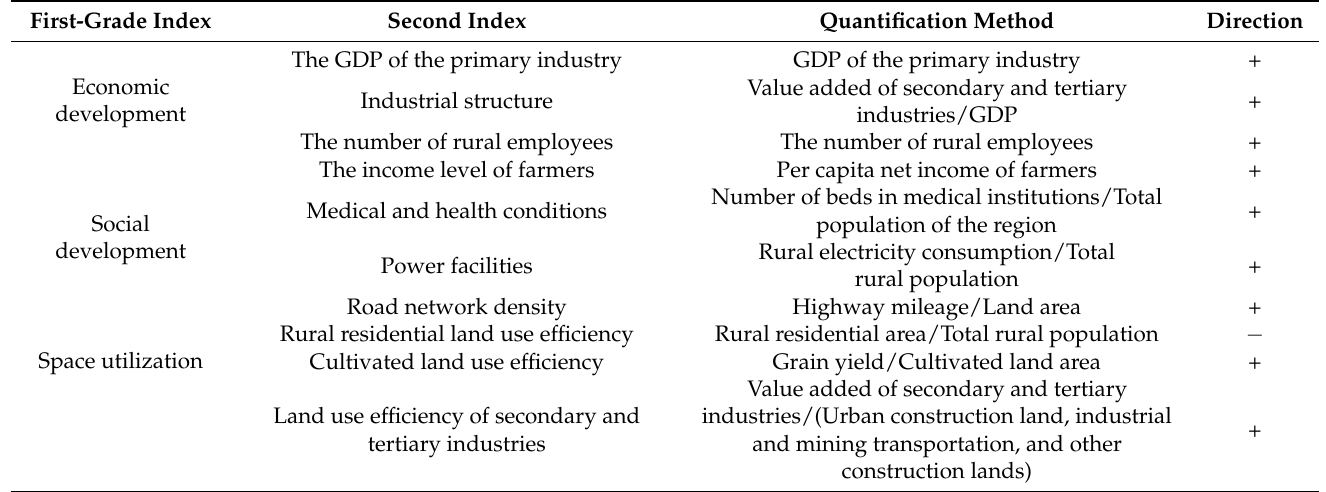
Table 1. Evaluation index system of rural development